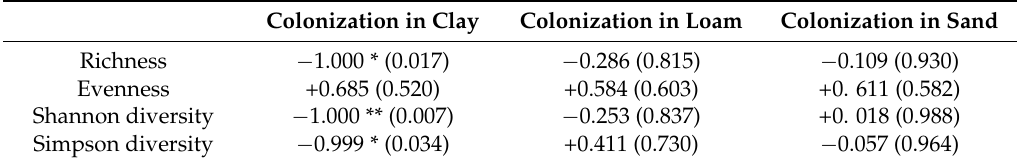
Table 2. Pearson correlation coefficients and significance levels between B068150 colonization and bacteria diversity indices in cucumber rhizosphere samples.